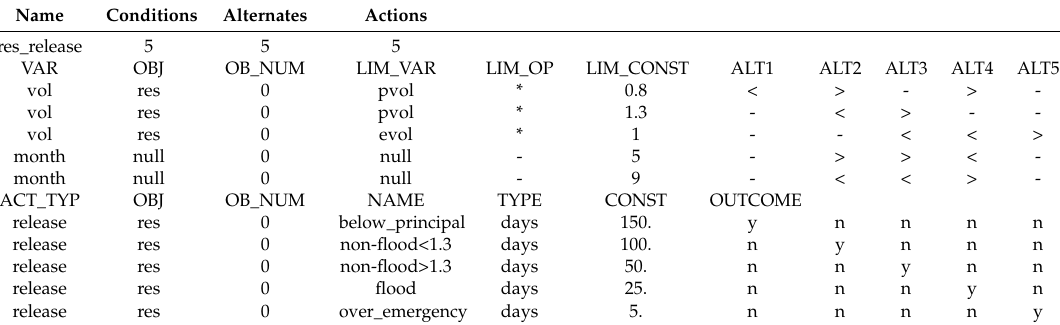
Table 6. Decision table for reservoir release focusing on flood control.